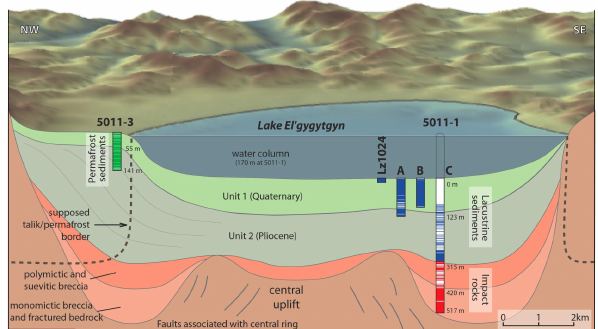
Figure 2. Schematic cross section of the El’gygytgyn basin stratig- raphy showing the location of ICDP Sites 5011-1 and 5011-3 (after Melles et al.,